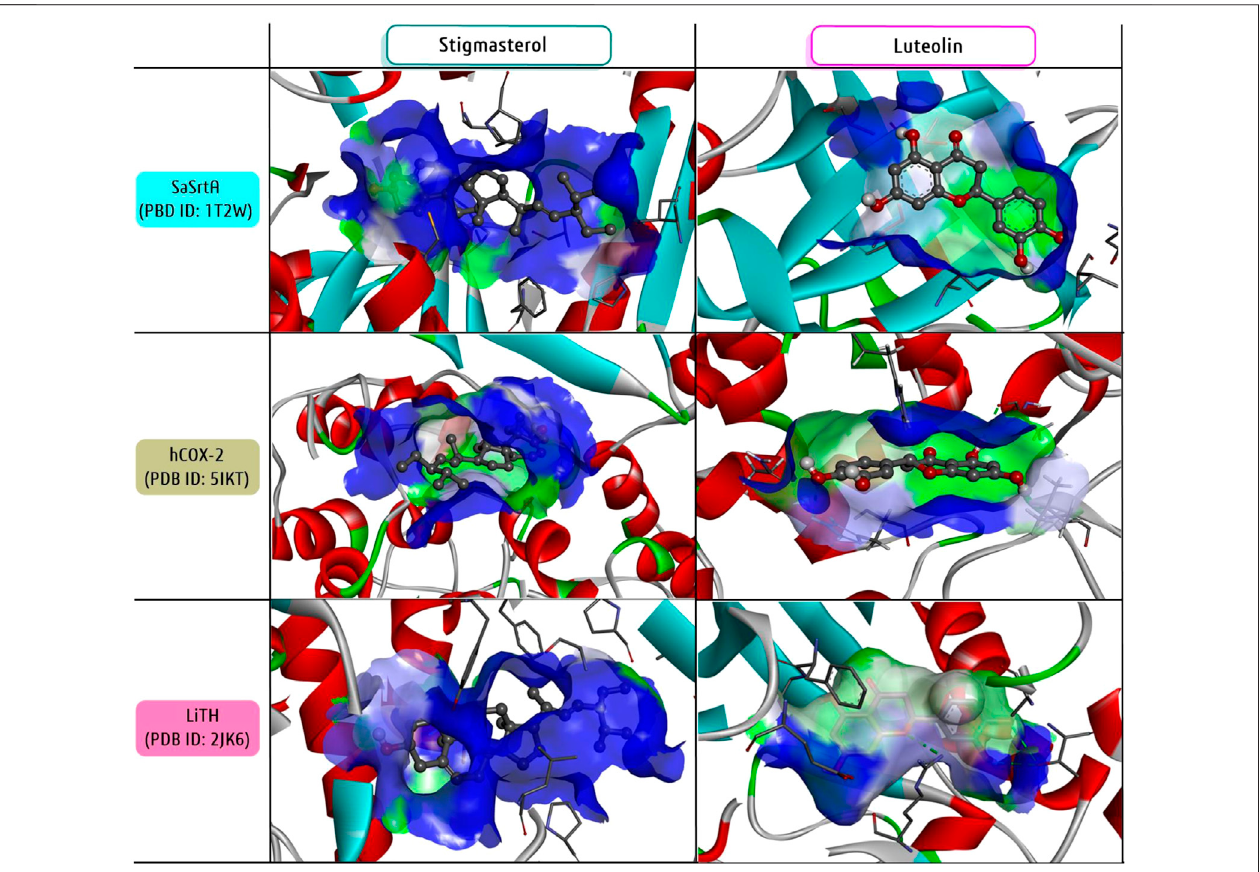
FIGURE 8 | Protein-ligand interactions of two most potential candidates, stigmasterol and luteolin against selected three candidates. The molecular interactions were presented using the software Discovery studio visualizer.